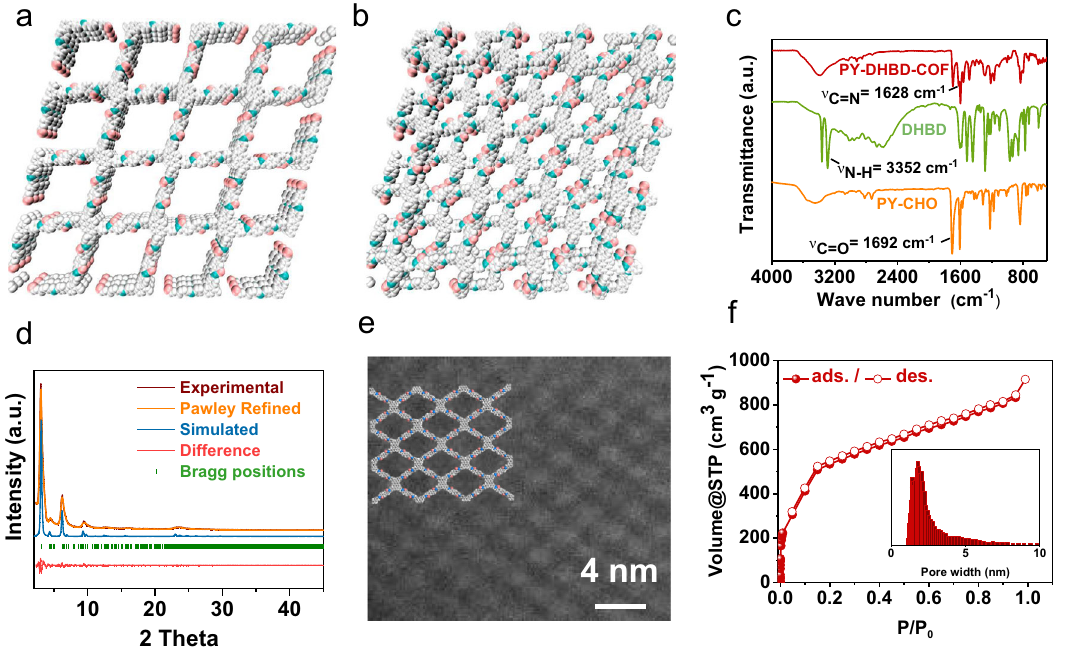
Fig. 2 Structural characterizations and morphology of PY-DHBD-COF. a AA-stacked structure and b AB-stacked structure of PY-DHBD-COF, the balls in different colors represent different atoms: C, gray; N, green; O, pink. c FT-IR spectra of PY-DHBD-COF, and the building monomers. d Experimental and simulated PXRD patterns of PY-DHBD-COF. e HAADF-STEM image of PY-DHBD-COF. f N 2 adsorption isotherms of PY-DHBD-COF. Insert: pore size distribution of